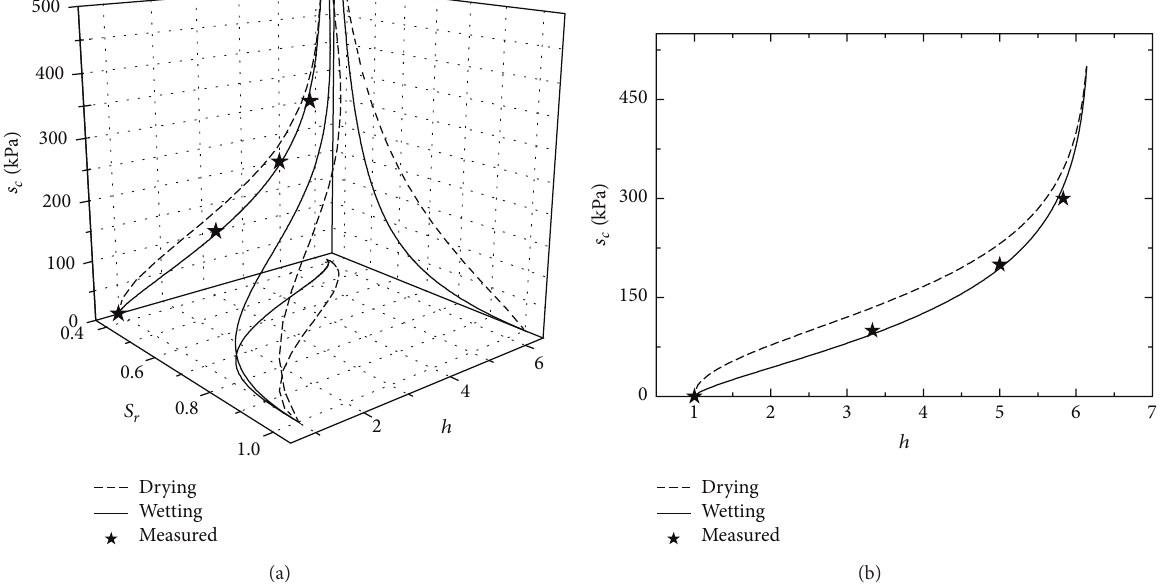
Figure 3: Relations among ℎ , 𝑠 𝑐 , and 𝑆 𝑟 : (a) three-dimensional view of the hardening surface; (b) projection of the hardening surface on the : ℎ plane (data after Wheeler and Sivakumar (1995) 𝑠 𝑐